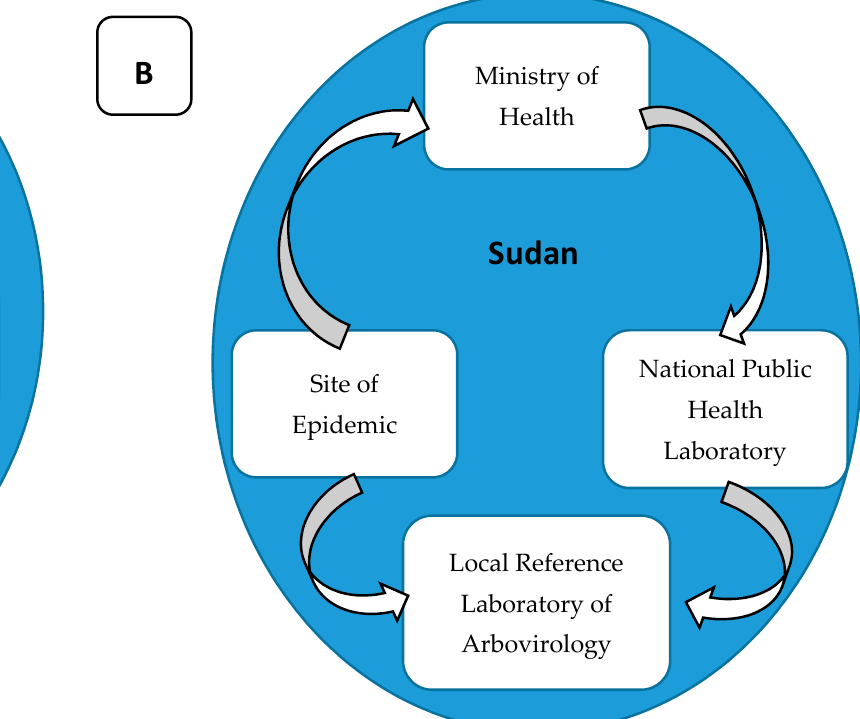
Figure 8. ( A ). Diagram of sample processing for suspected arboviral infections from the field to the confirmation of the arboviral infection. ( B ). Proposed protocol for local, rapid detection and confirmation of arboviral infections based on the establishment of a local, advanced reference laboratory for arbovirology to confirm infections and support the national disease surveillance system.